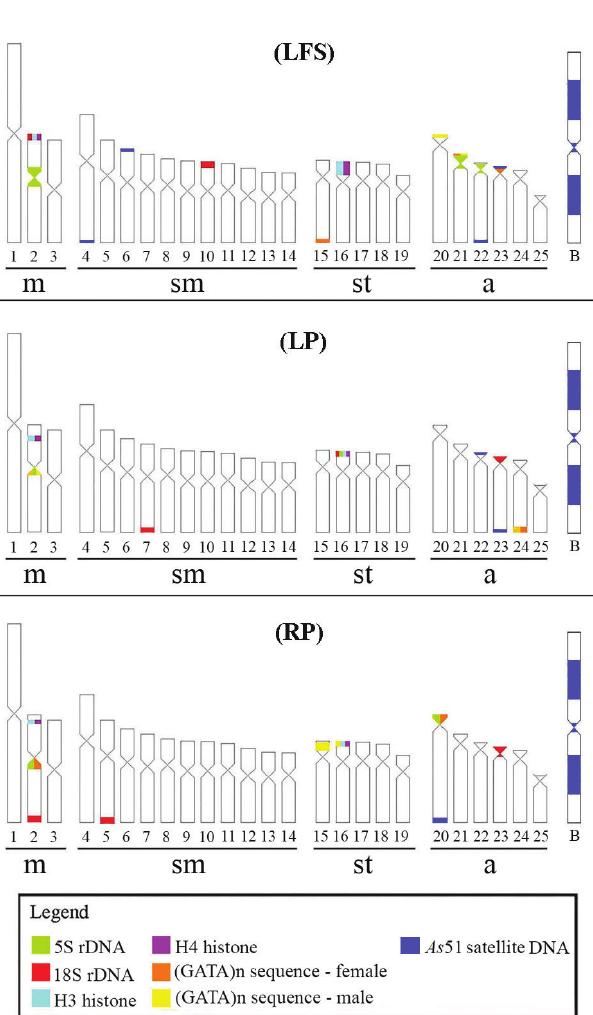
Figure 5. Idiograms of the three Astyanax scabripinnis populations (LFS: Lavrinha Farm Stream); (LP: Lake of Pedalinho); (RP: Ribeirão das Perdizes) highlighting all markers of molecular cytogenetics used in this